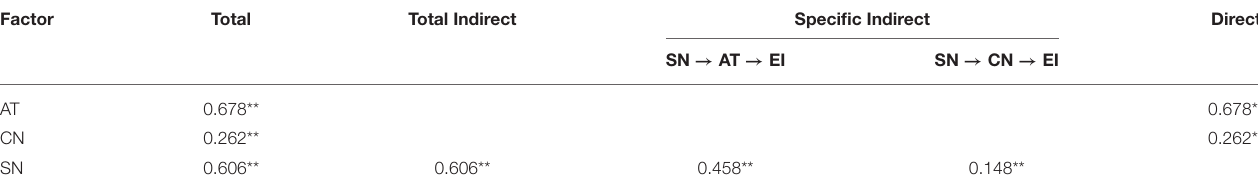
TABLE 7 | Direct and indirect effects. Factor